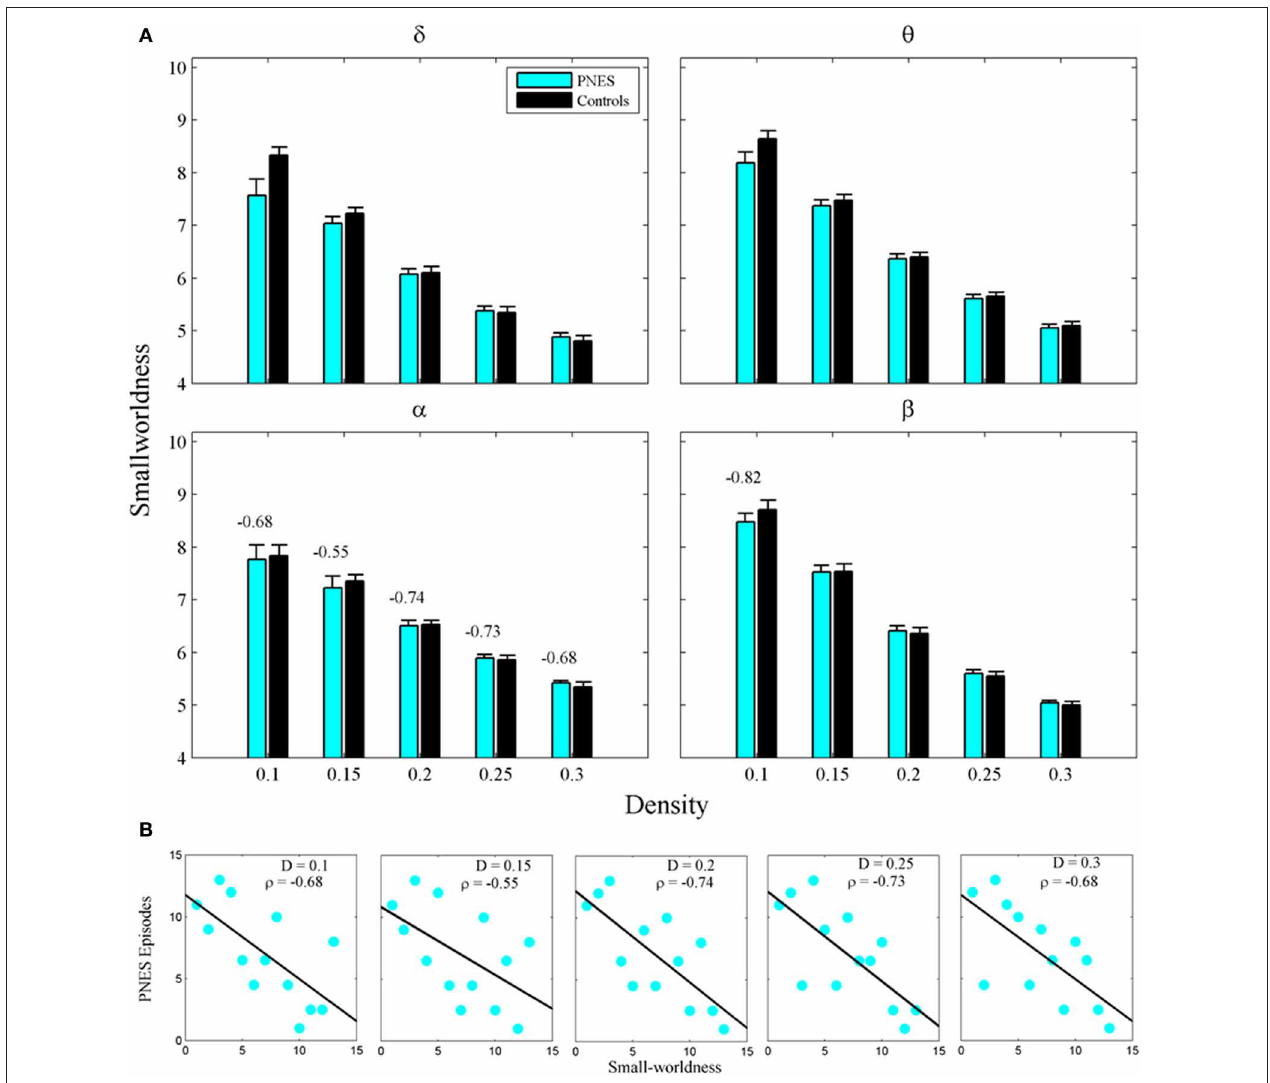
FIGURE 4 | Small-worldness as a function of network density for PNES patients and controls. (A) The plots show the small-worldness index of functional brain networks as a function of density in PNES patients and controls. (B) Scatterplots for